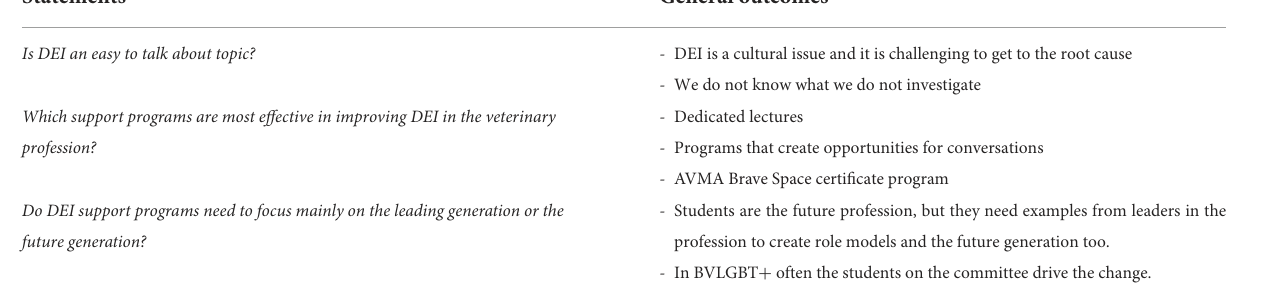
TABLE 4 Panel discussion outcomes of the DEI